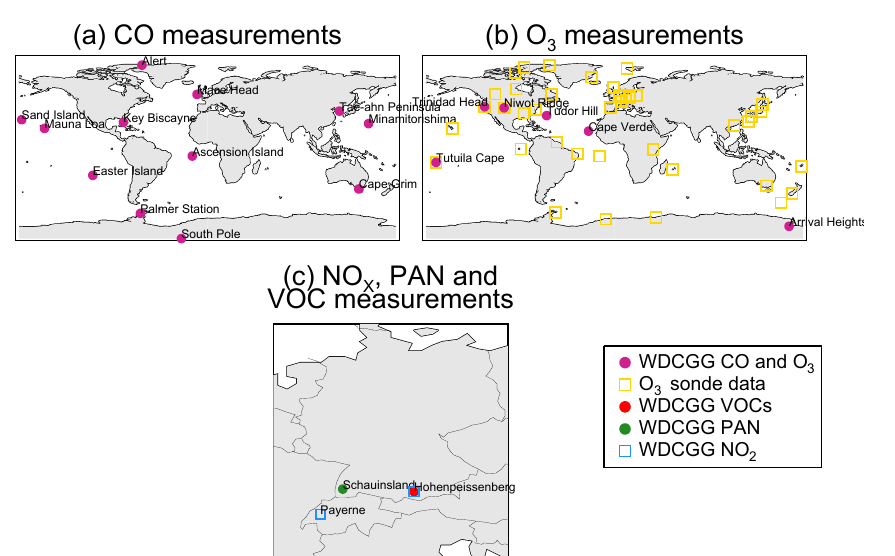
Figure 2. Location of the World Data Centre for Greenhouse Gases (WDCGG) surface observatories and ozonesonde release sites used to evaluate the model for (a) CO, (b) O 3 and (c) PAN, NO x and